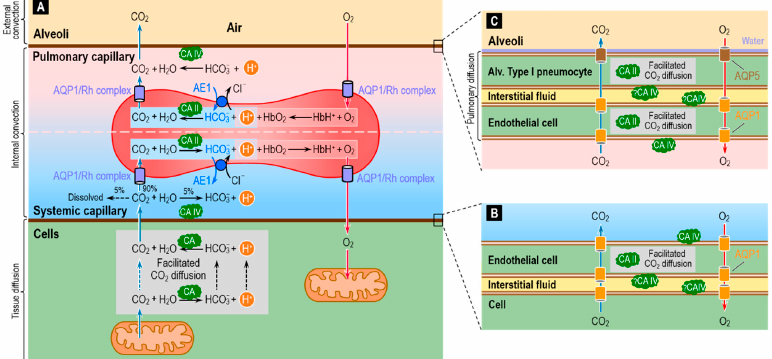
Figure 9. Diagram of the reaction, di ff usion and transport processes involved in the removal of the metabolically produced CO 2 from cells to blood (systemic capillary) and from blood (pulmonary capillary) to the lung (alveoli). ( A ) Of the CO 2 that di ff uses from cells to the systemic capillary, ~10% remains in the blood plasma—as dissolved CO 2 (~5%), HCO 3 − (~5%) or carbamino compounds ( < 1%)—whereas ~90% enters the RBCs, almost entirely via the water channel AQP1 [104] or the Rh complex [72]. In the cytosol of the RBCs, most CO 2 rapidly combines with H 2 O to form HCO 3 − and H + , under the catalytic action of CA I (not shown) and CA II. Much of this newly formed HCO 3 − exits via the Cl-HCO 3 exchanger AE1 [105,106]. A smaller fraction of the incoming CO 2 covalently reacts with hemoglobin (Hb) to form carbamino-Hb and H + , and a tiny fraction remains dissolved in the RBC cytosol. Hb bu ff ers nearly all of the newly formed H + [58,107]. These events all reverse in the pulmonary capillary, where RBCs unload CO 2 for di ff usion into the alveolar space.